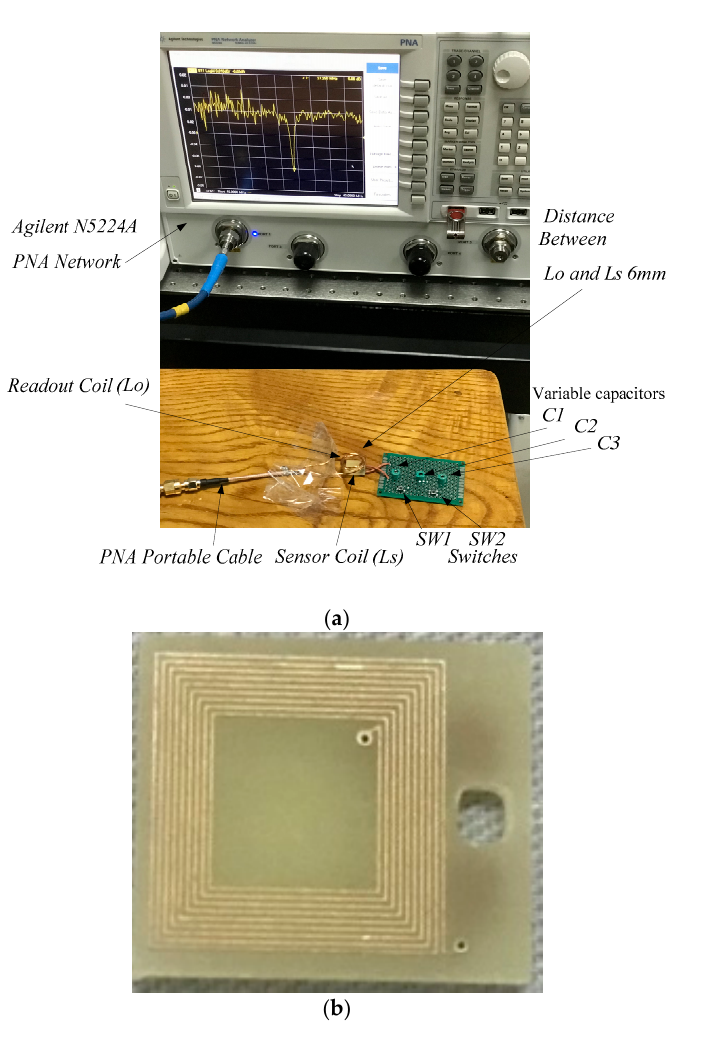
Figure 7. Experiments of the LC sensor system. ( a ) Experimental platform of readout coil and monitoring sensor system. ( b ) PCB planar square copper inductor.